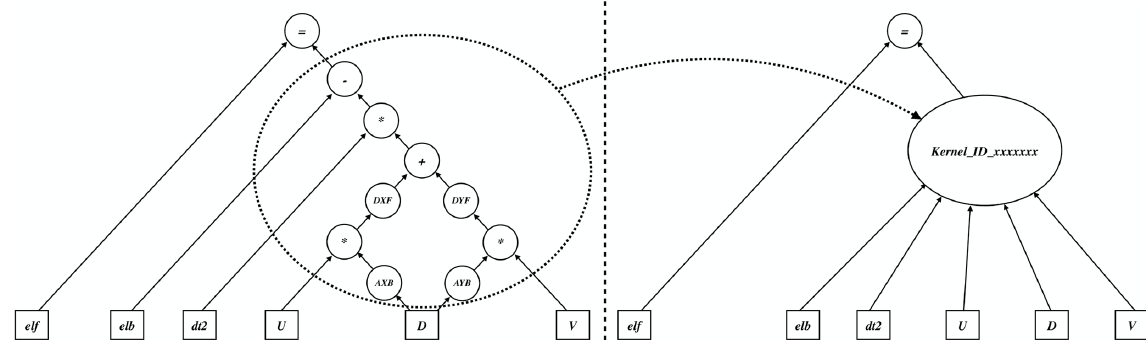
Figure 8. The schematic diagram of kernel